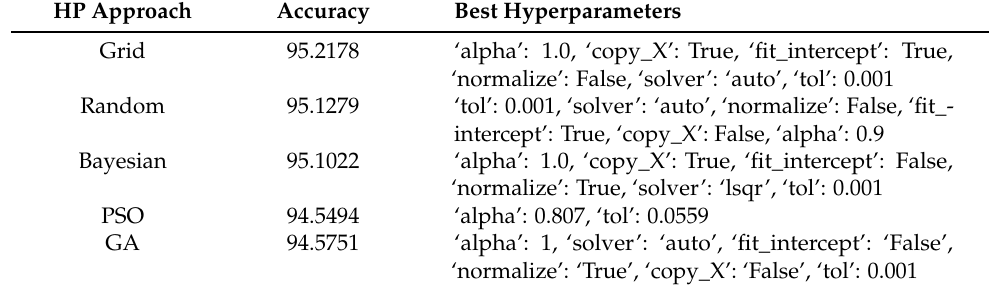
Table 2. Hyperparameter tuning for Ridge Classifier.